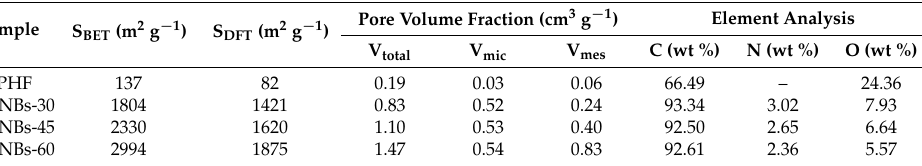
Table 1. Surface properties and element analysis of NCNBs.